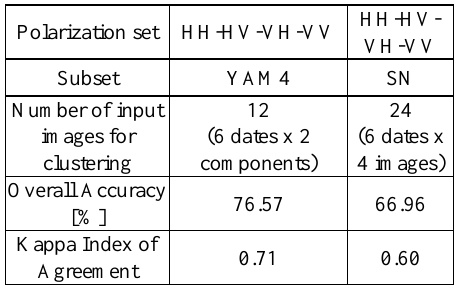
Table 3. The results of Accuracy Assessment for subsets A,B extracted from Experimental Quad-Pol data for 6 classes. Figure 4 represents classification results of the subset A showing higher Overall Accuracy and Kappa Index.